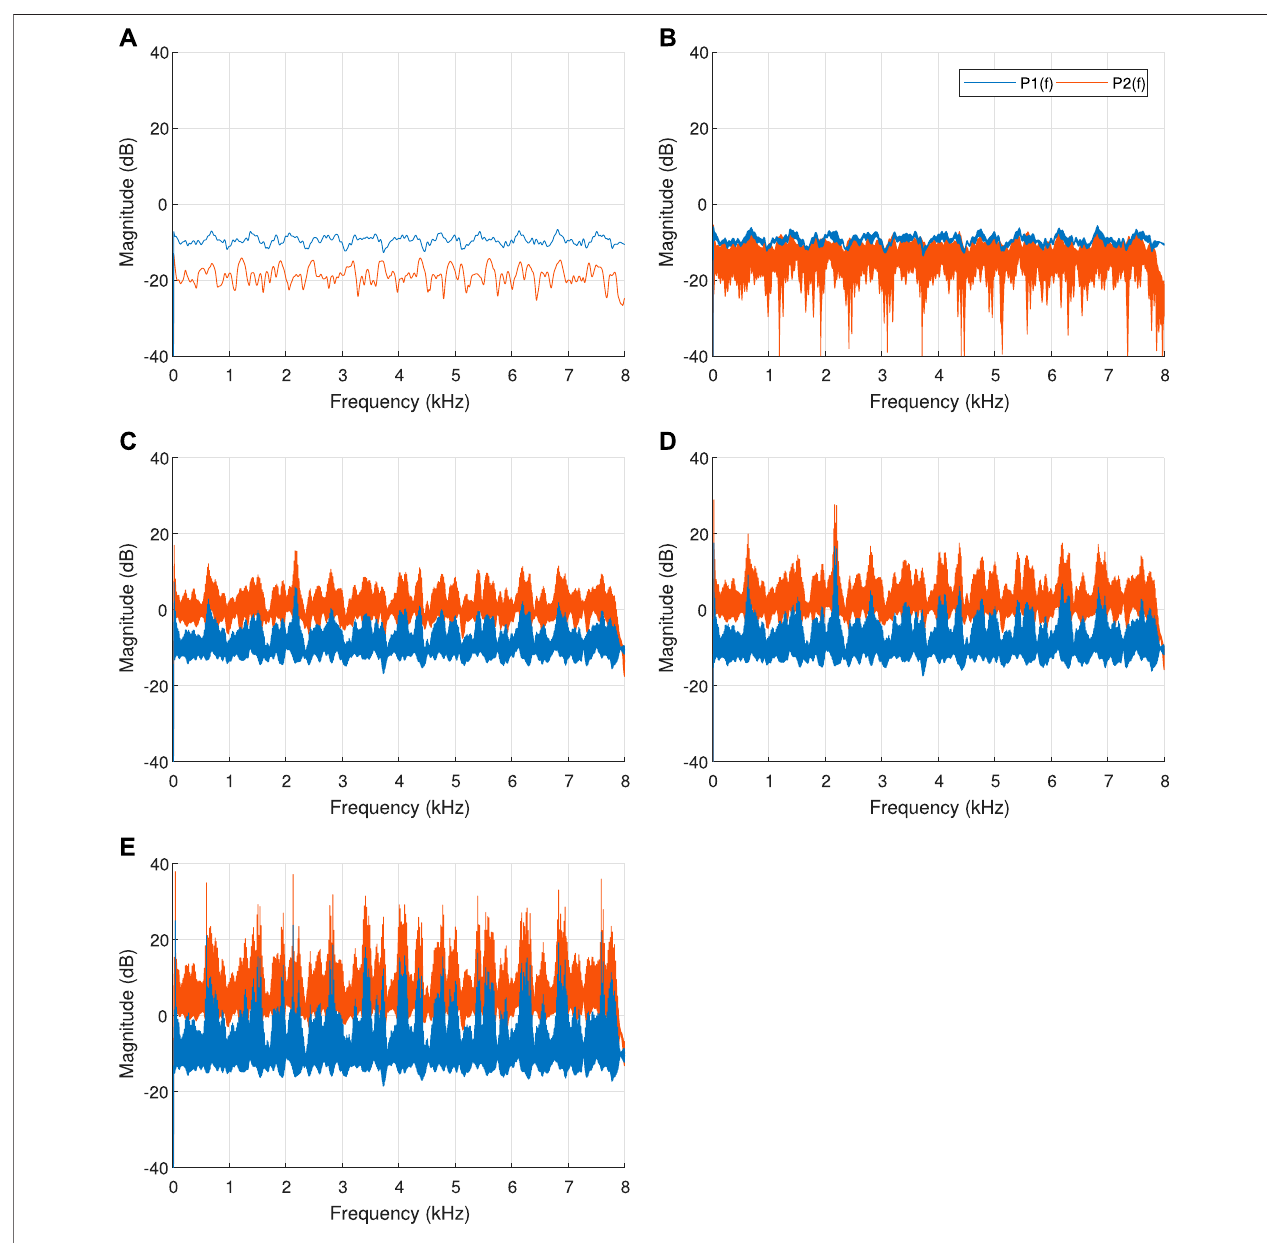
FIGURE 2 | Magnitude-response (dB) graphs of the frequency responses P 1 ( f ) and P 2 ( f ), for different ampli fi cation-gains, where mic2 ’ s location is [ 0 . 875 , 1 . 5 , 1 ] : (A) K = 0; (B) K = 1; (C) K = 5; (D) K = 6; (E) K = 8.